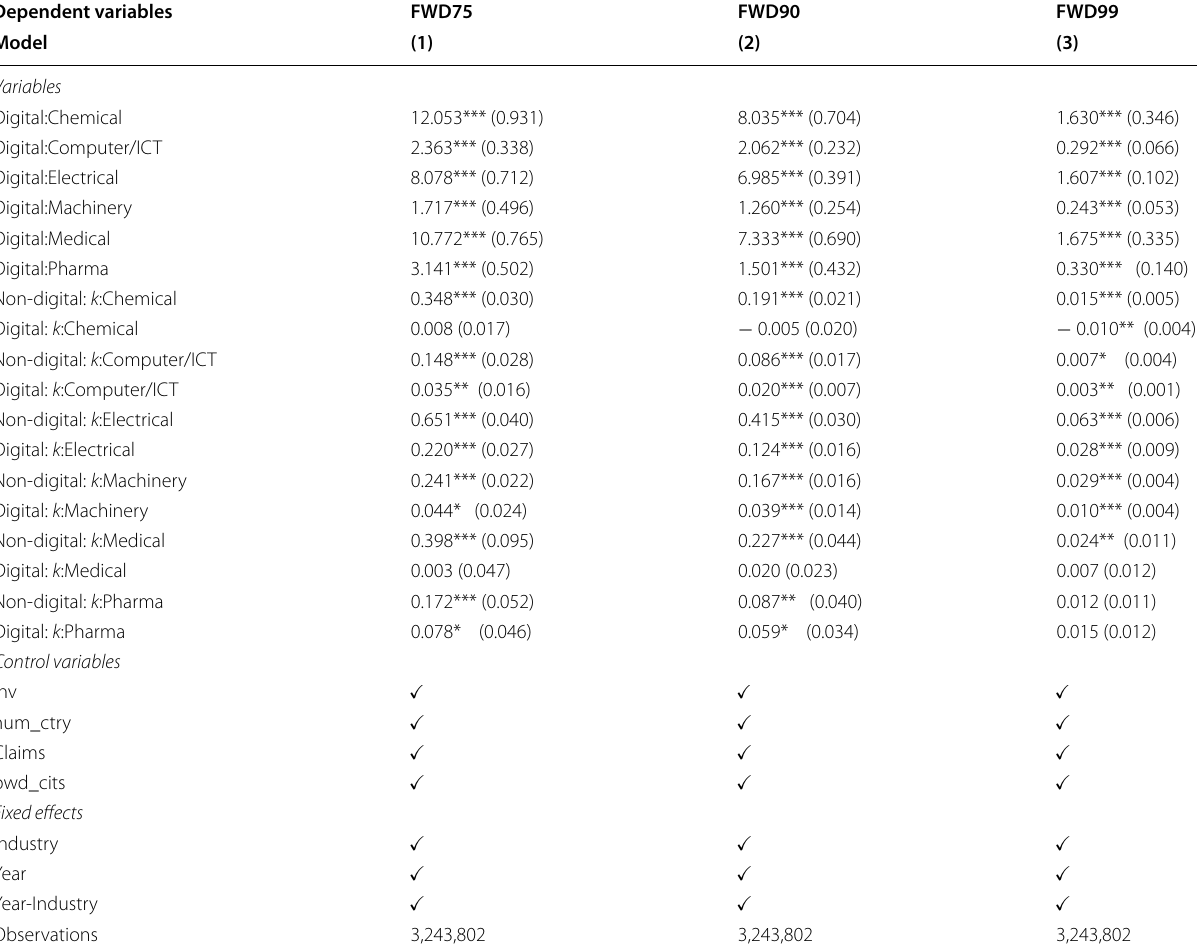
Table 13 Technological improvement rates and breakthrough innovations: breakthrough measures across industries (part